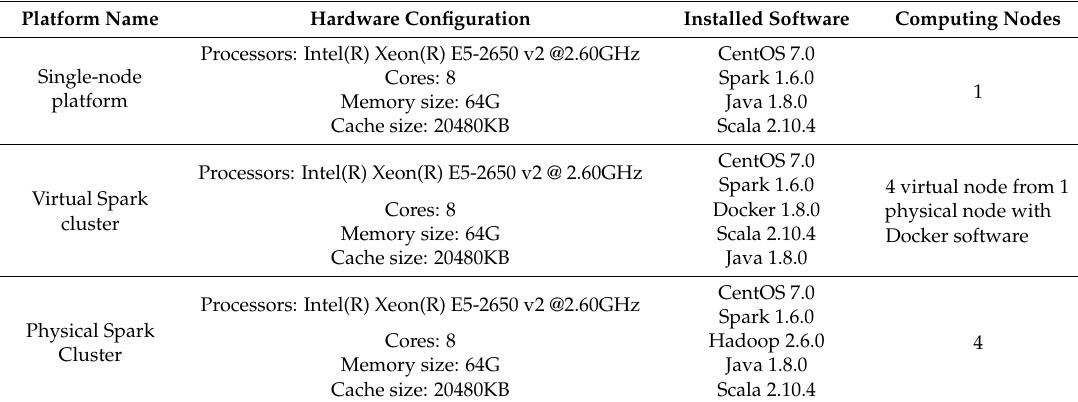
Table 6. Experimental platforms’ configuration information.